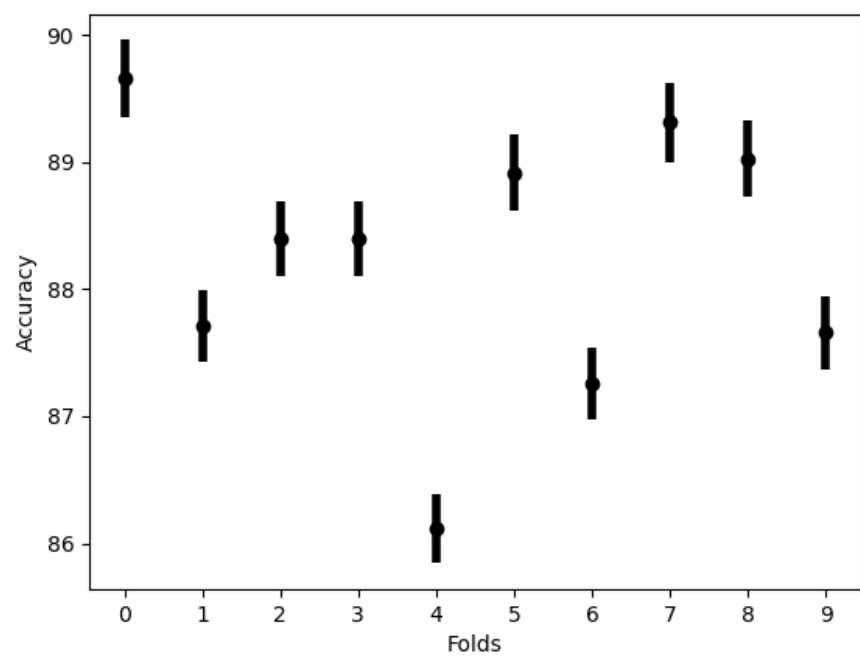
Figure 4. The 10-fold cross-validation results for the trained SNN model using the IMDb model, which has been used on the MR and Amazon